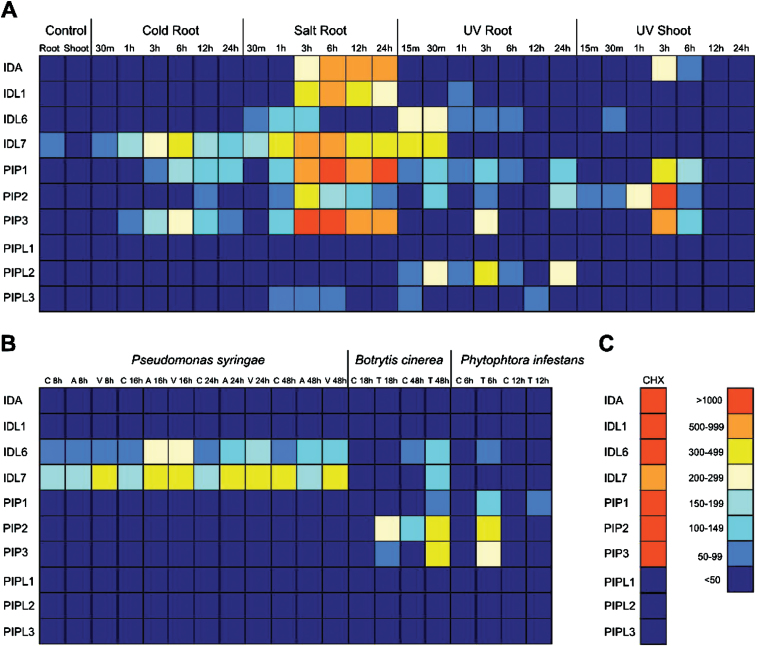
Stress-induced expression of IDA/IDL and PIP/PIPL genes based on in silico data. (A) Abiotic stress. Cold root, root tissue collected from cold-treated seedlings (continuous 4°C); salt root, root tissue collected from salt-treated seedlings (150mM NaCl); UV root/shoot, root and shoot tissue collected from UV-treated seedlings (15min treatment in UV-B field). (B) Biotic stress. Pseudomonas syringae half-leaf infiltration: C, control (10mM MgCl2); A, avirulent P. syringae ES4326 avrRPt2; V, virulent P. syringae ES4326. Botrytis cinerea treatments: C, control (potato dextrose broth); T, treated (B. cinerea 5×105 spores/ml). Phytophthora infestans treatments: C, control (water); T, treated (Phytophthora infestans 106 spores/ml). (C) Cycloheximide (CHX) treatment (10 μM CHX, 3h). All data was obtained from the Arabidopsis eFP browser at the Bio-Array Resource database (Winter et al., 2007). The arithmetic expression values are given next to the colour scale.